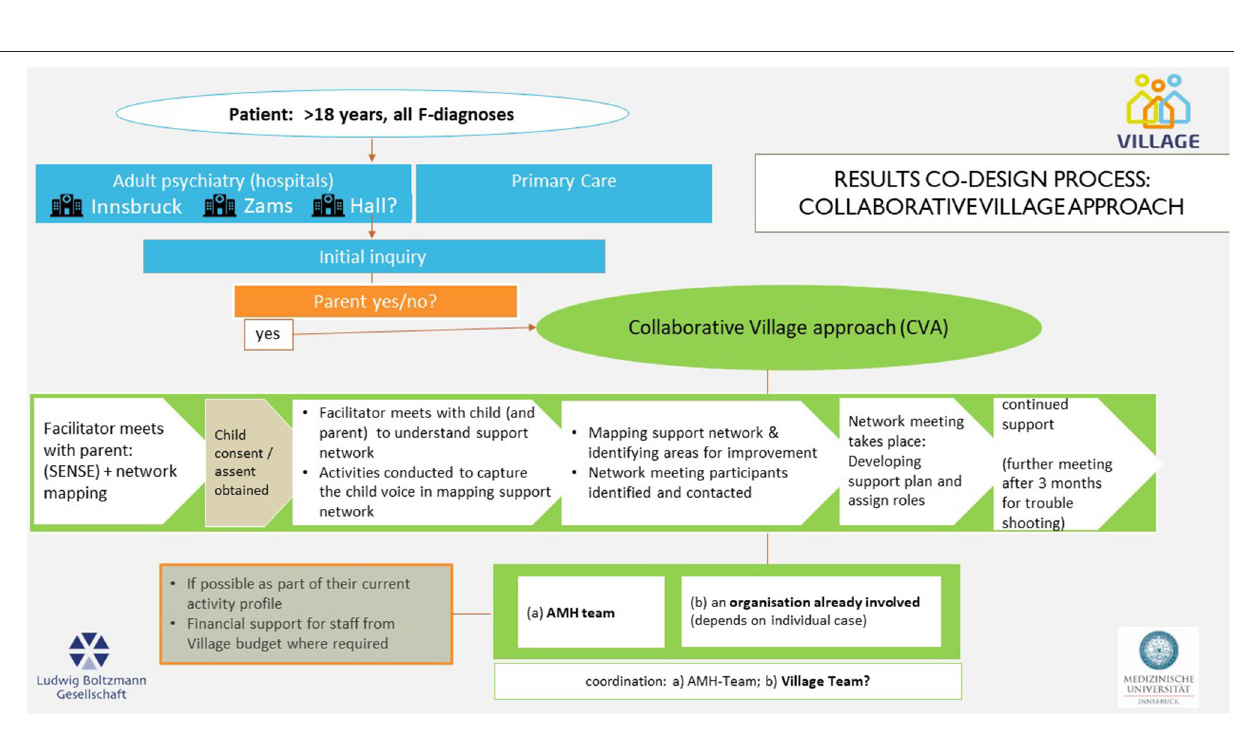
FIGURE 2 | Pathway for the Collaborative Village Approach